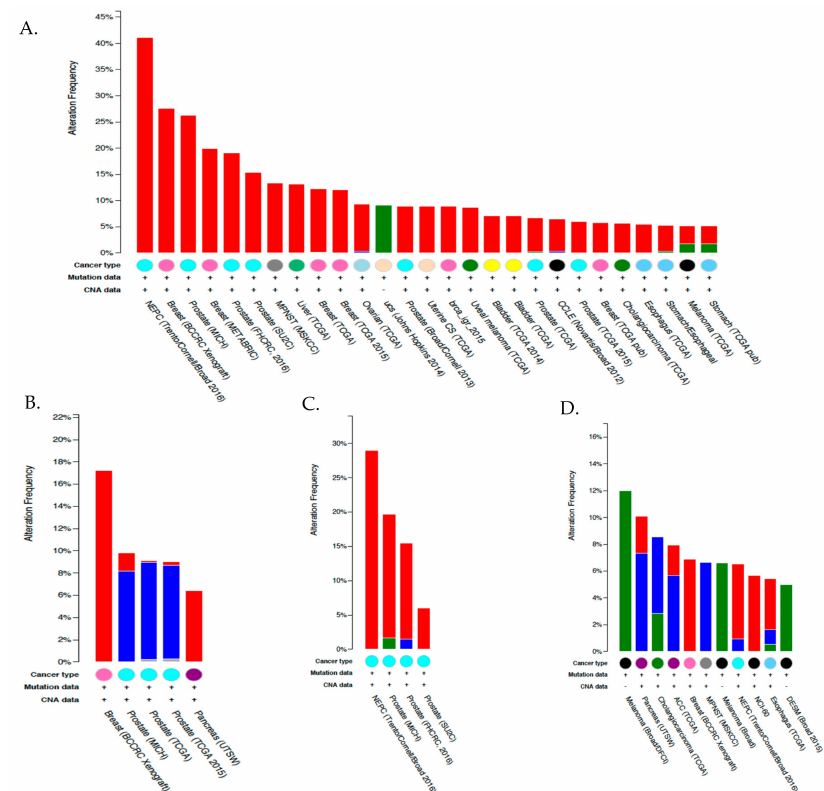
Figure 4. Summary of cross-cancer alterations for CA isoforms. ( A ) Cytosolic isoform CA XIII, ( B , C ) mitochondrial isoforms CA VA, and CA VB, respectively, and ( D ) secreted isoform CA VI. Gene amplifications are shown in red, mutations in green, deletions in blue, and multiple alterations in gray. The minimum percent altered samples threshold was set to 5%. The data and results were obtained from the cBioPortal of the TCGA database [141,142]. Experimental details of each study referenced can also be found in the TCGA